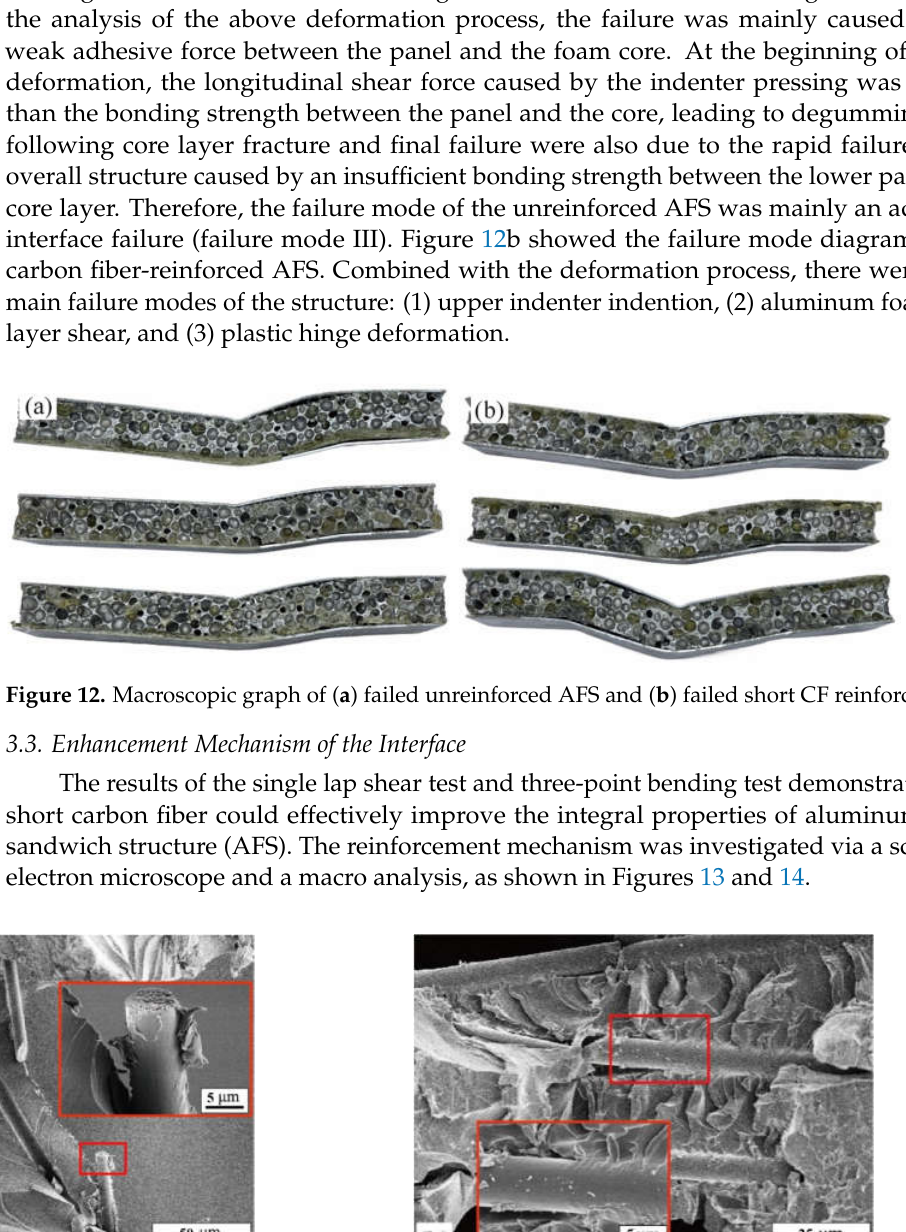
Figure 11. Load-displacement curves of ( a ) adhesive bonded AFS [39] and ( b ) metallurgical bonding AFS [39] (Pictures a and b are copied from other published papers, if original pictures were needed, please check the references.).